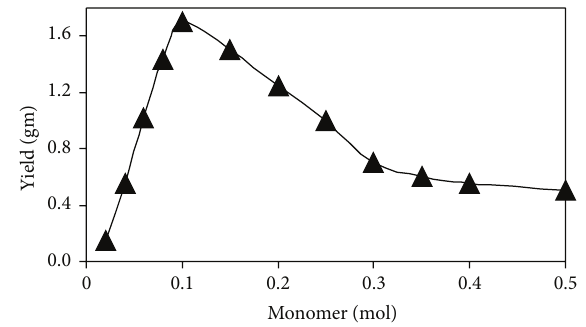
Figure 1: Yield-K 2 Cr 2 O 7 concentration effect on the aqueous oxidative polymerization of poly-o-phenylenediamine (POPDA).